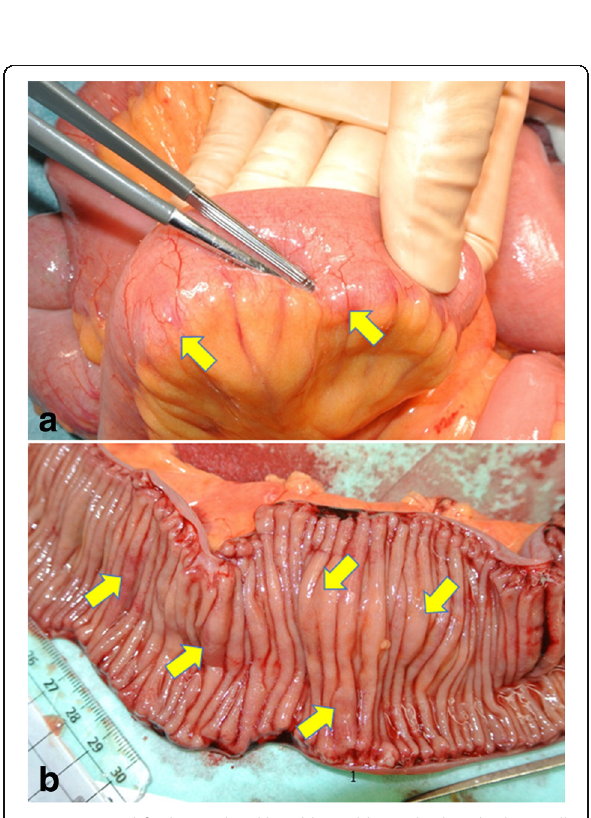
Fig. 2 Surgical findings. The dilated bowel loops had multiple, small, intramural nodules. The gas-filled cysts were palpated as elastic nodules located in the bowel walls ( a ) and appeared like multiple submucosal tumors covered with normal mucosa in the resected specimen ( b ). Arrows indicate